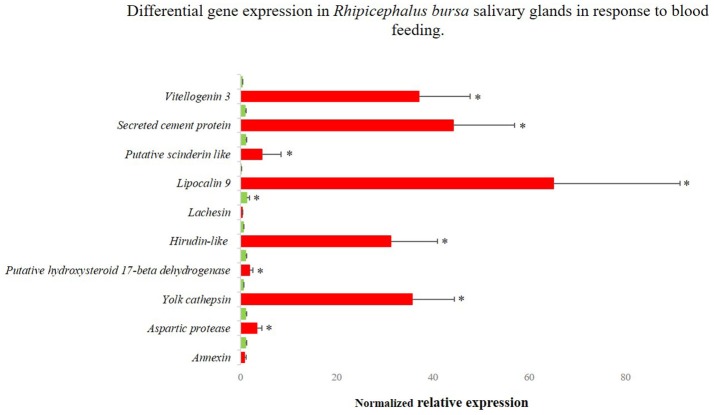
Differentially gene expression of Rhipicephalus bursa SG in response to blood feeding evaluated by qPCR. Red bars represent SG from fed R. bursa ticks and green bars represent the SG from unfed R. bursa ticks. *P < 0.05.